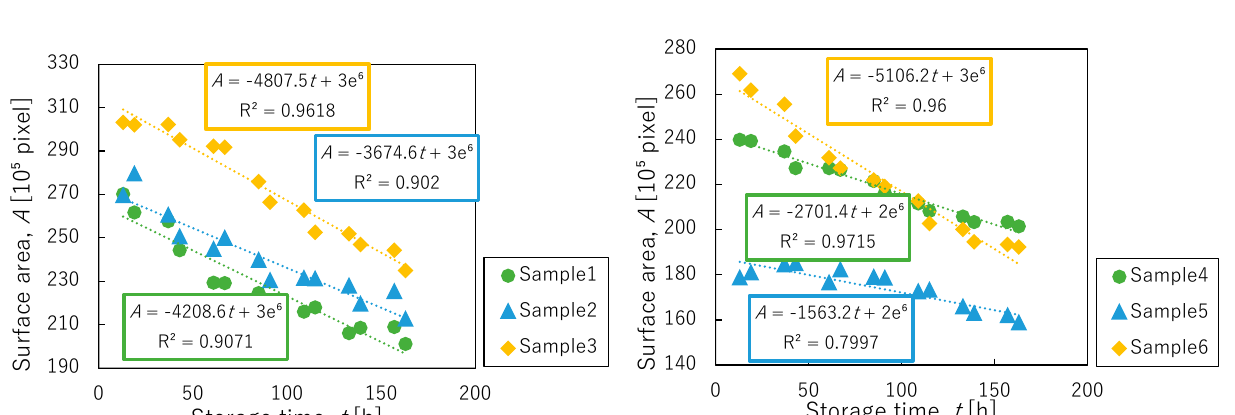
Fig. 13: Projected area (A) change of lettuce FFiigg.. 1133 PPrroojjeecctteedd aarreeaa ((AA)) cchhaannggee ooff lleettttuuccee hheeaadd 708